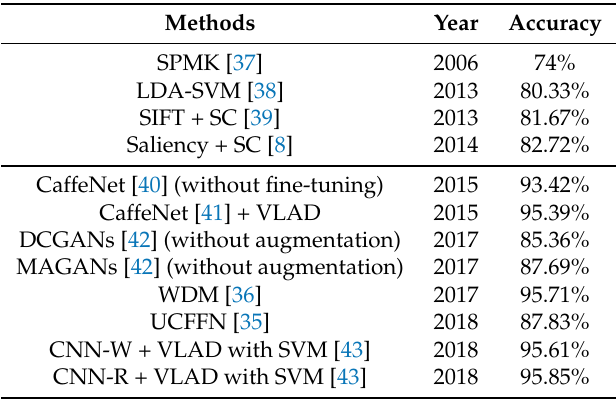
Table 2. Experiment on UC-Merced dataset